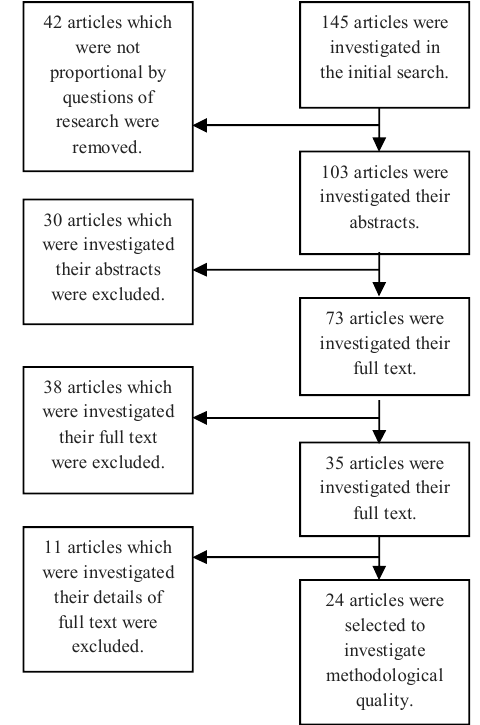
Fig. 2. Process of search and selection selecting of appropriate articles in the field of e-learning security